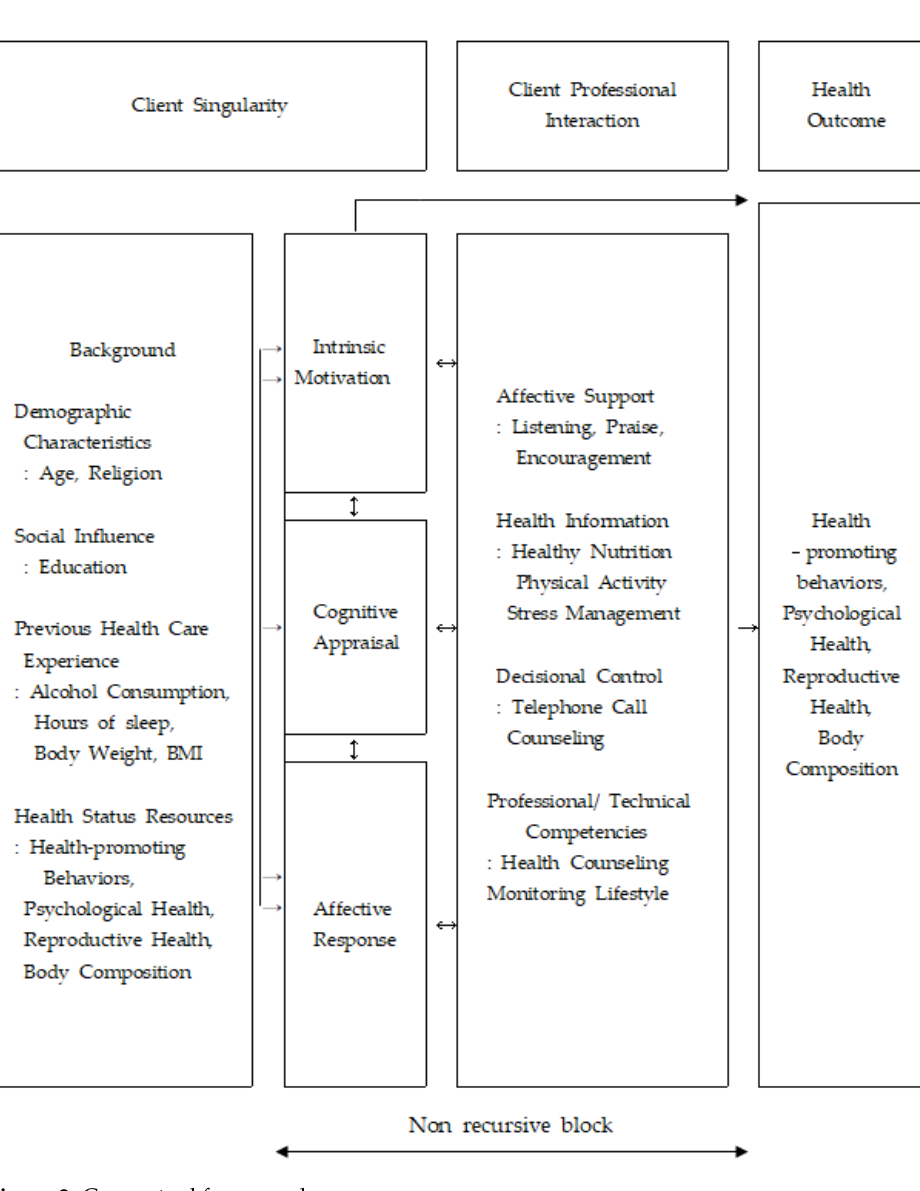
Figure 2. Conceptual